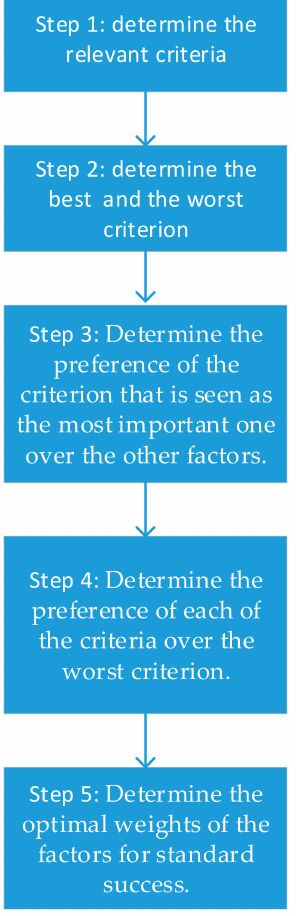
Figure 1. The best–worst method (BWM) procedure.